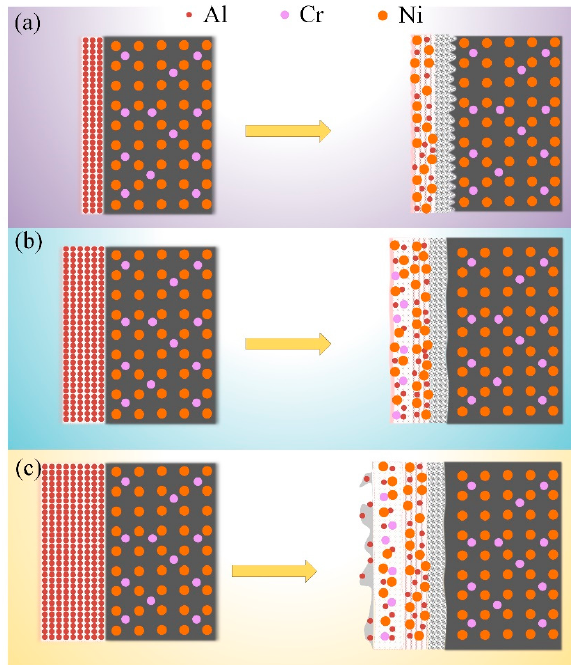
Figure 9. Schematic diagram of slurry aluminization for ( a ) thin, ( b ) medium, and ( c ) thick slurry